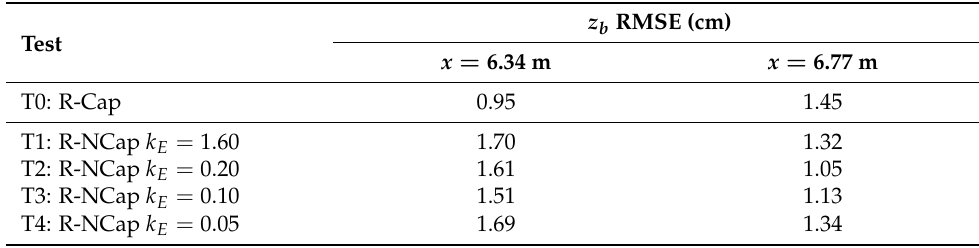
Table 8. Bed level z b RMSE for the profiles x = 6.34 m and x = 6.77 m with the R-Cap and R-NCap